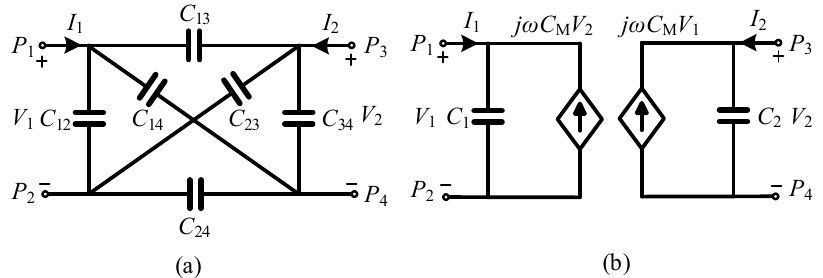
Figure 3. The modeling of capacitive coupler structure. ( a ) Full-capacitor model. ( b ) Induced current source model.